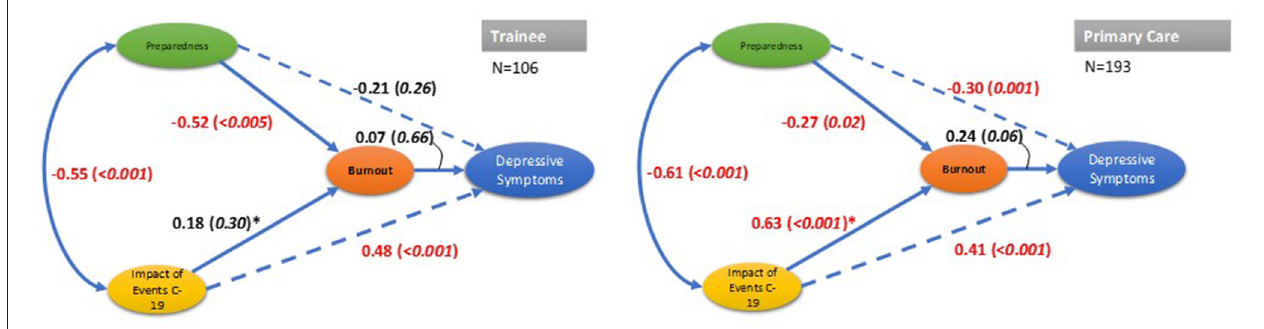
FIGURE 2 | Result of path models for trainee and primary care staff groups (standardized coefficients presented with p values in brackets). Overall model fit statistics, Chi-square(d f 54) = 95.82, p = 0004; CFI = 0.97; RMSEA = 0.072, 95%CIs: 0.48, 0.95; Group fit statistics: SRMR = 0.006 (Trainee), 0.038 (primary care); *Association significantly different between groups: chi-square (d f 1) = 11.95, p = 0.005. Indicator raw variables omitted to improve legibility; significant associations in red